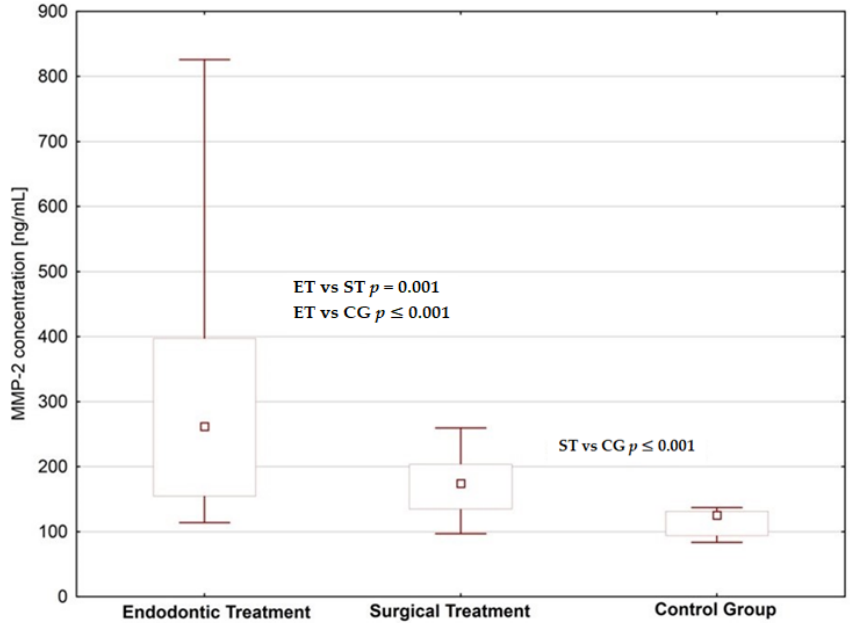
Figure 2. Saliva MMP-2 concentrations in patients planned for endodontic and surgical dental treatment in comparison to the control group.